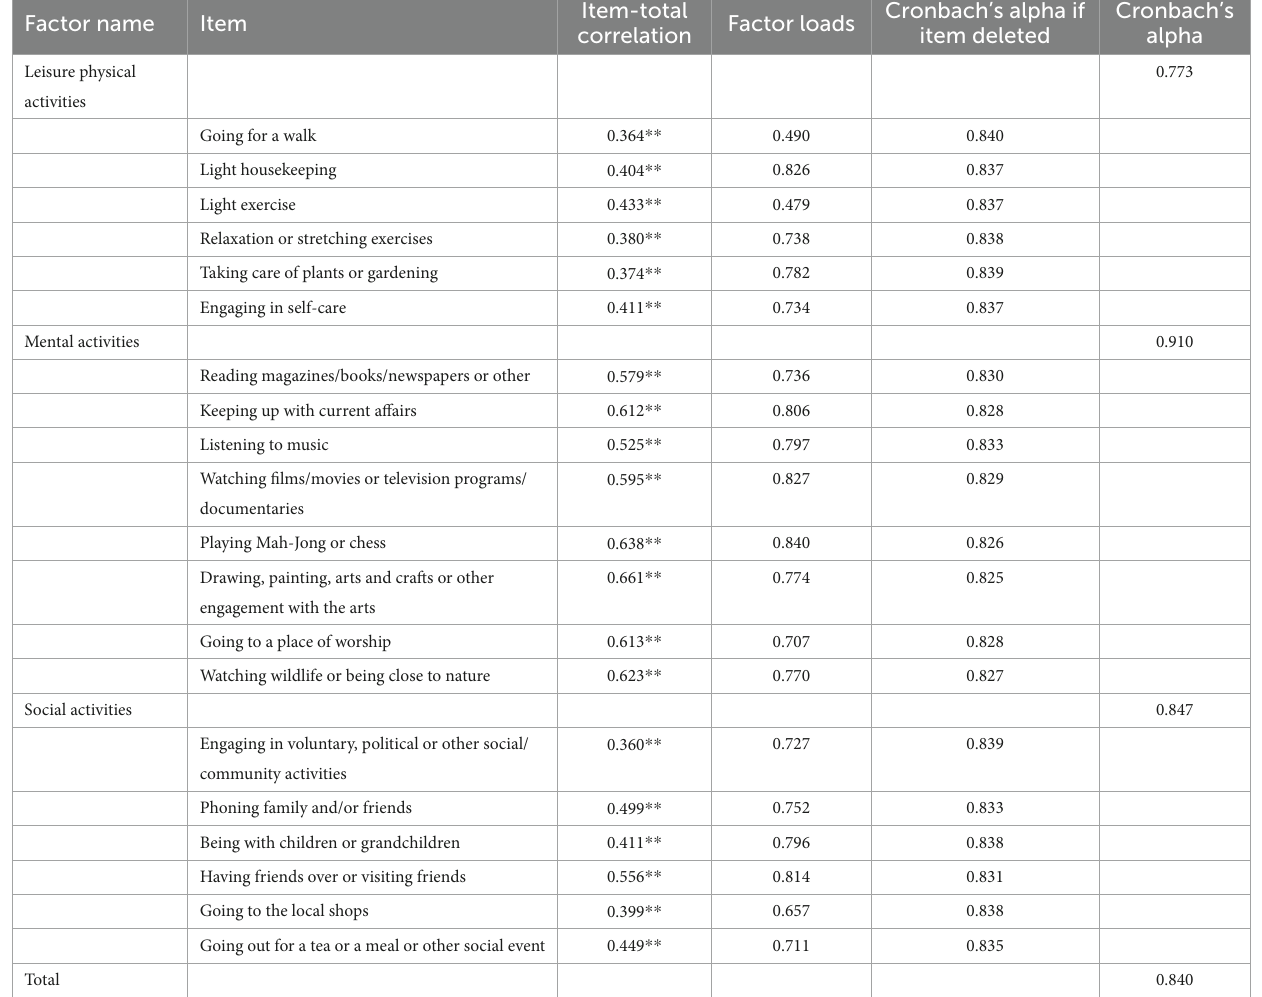
TABLE 2 Item-total correlation, reliability coefficients and factor loads of the C-MEAS ( N =